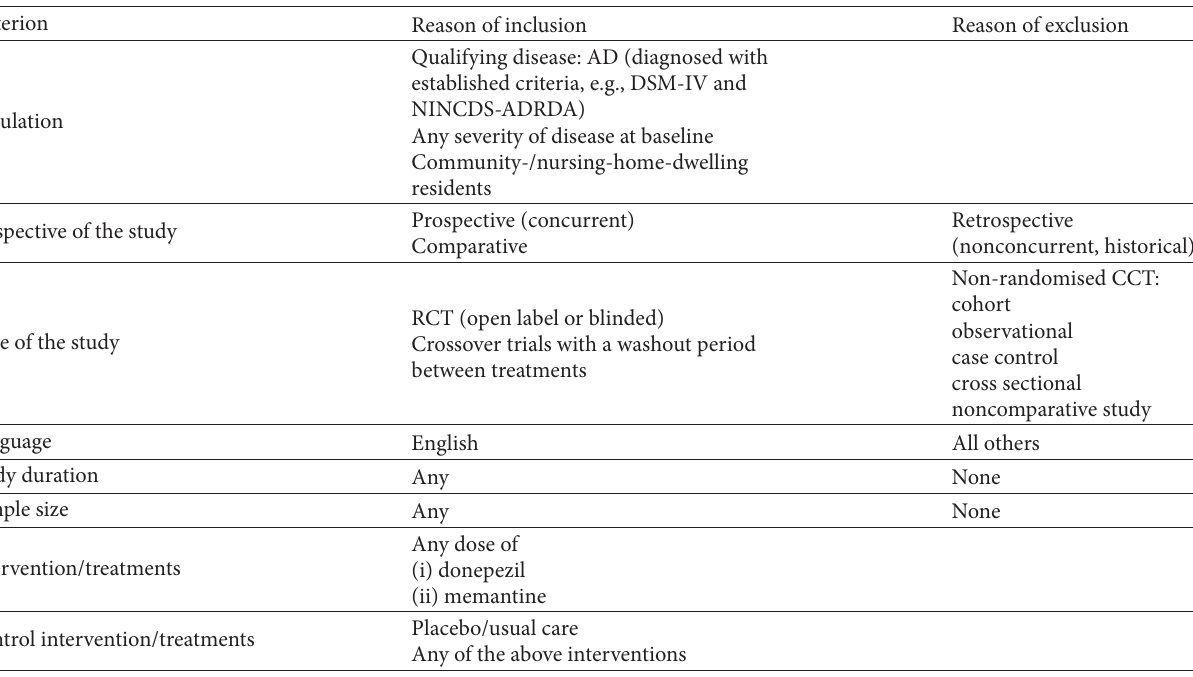
Table 1: Inclusion and exclusion criteria of papers selected for this review.